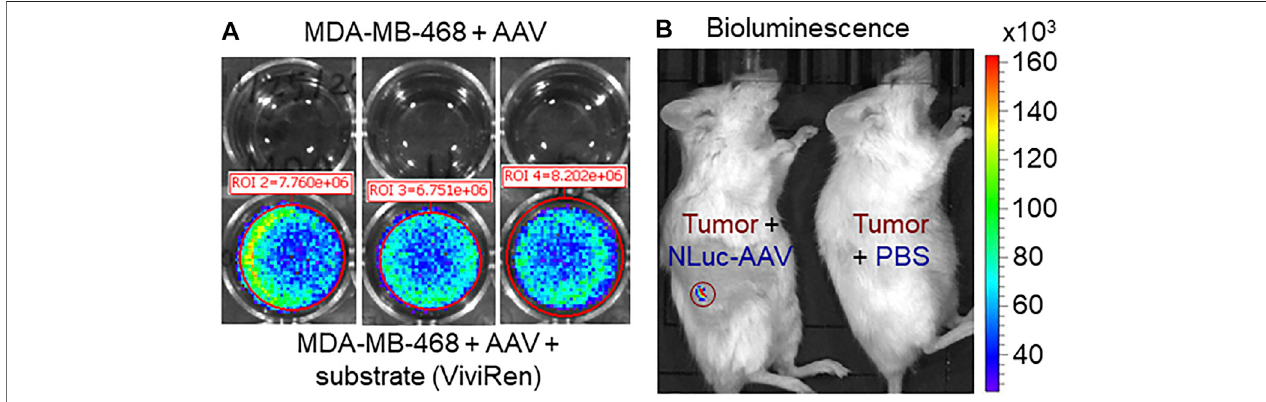
FIGURE 6 | Evaluation of AAV transfection/infection capability. (A) In vitro transfection and gene expression of AAV in TNBC MDA-MB-468 cells. Multiplicity of infection (MOI): 10,000. Live-cell In Vivo Imaging System (IVIS) image was taken 3 days after transfection. (B) In vivo infection and gene expression of AAV in TNBC xenograft model. Live-animal IVIS image was taken 7 days post AAV